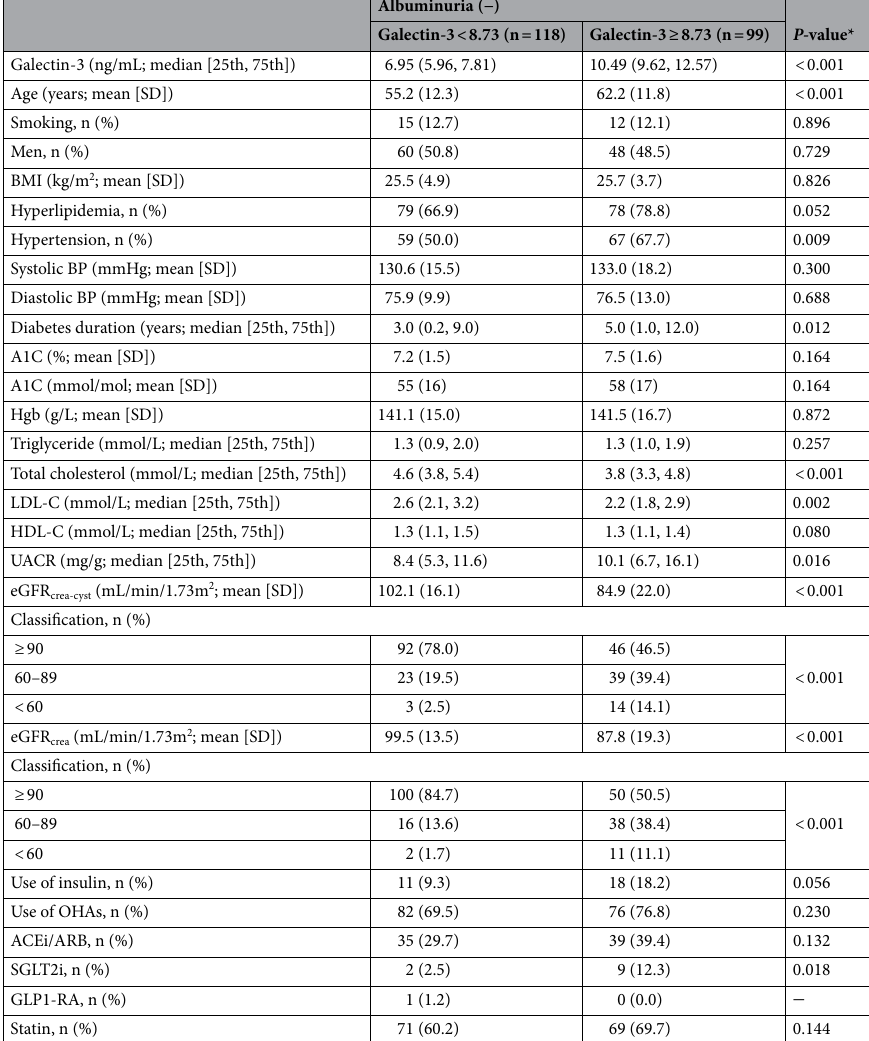
Table 2. Characteristics of patients with T2DM without albuminuria. Median galectin-3 for all patients (8.73 ng/mL) was unequally divided into normoalbuminuric and albuminuric groups. Data presented as mean (SD) and median (25th, 75th percentile). A1C glycated hemoglobin, ACEi angiotensin converting enzyme inhibitor, ARB angiotensin II receptor blocker, BMI body mass index, BP blood pressure, eGFR estimated glomerular filtration rate, GLP1-RA glucagon-like peptide-1 receptor agonist, Hgb hemoglobin, HDL-C high- density lipoprotein cholesterol, LDL-C low-density lipoprotein cholesterol, OHA oral hypoglycemic agent, and nonparametric continuous variables (diabetes duration, triglyceride, total cholesterol, LDL-C, HDL-C, Galectin-3, and UACR); the chi-squared test for categorical